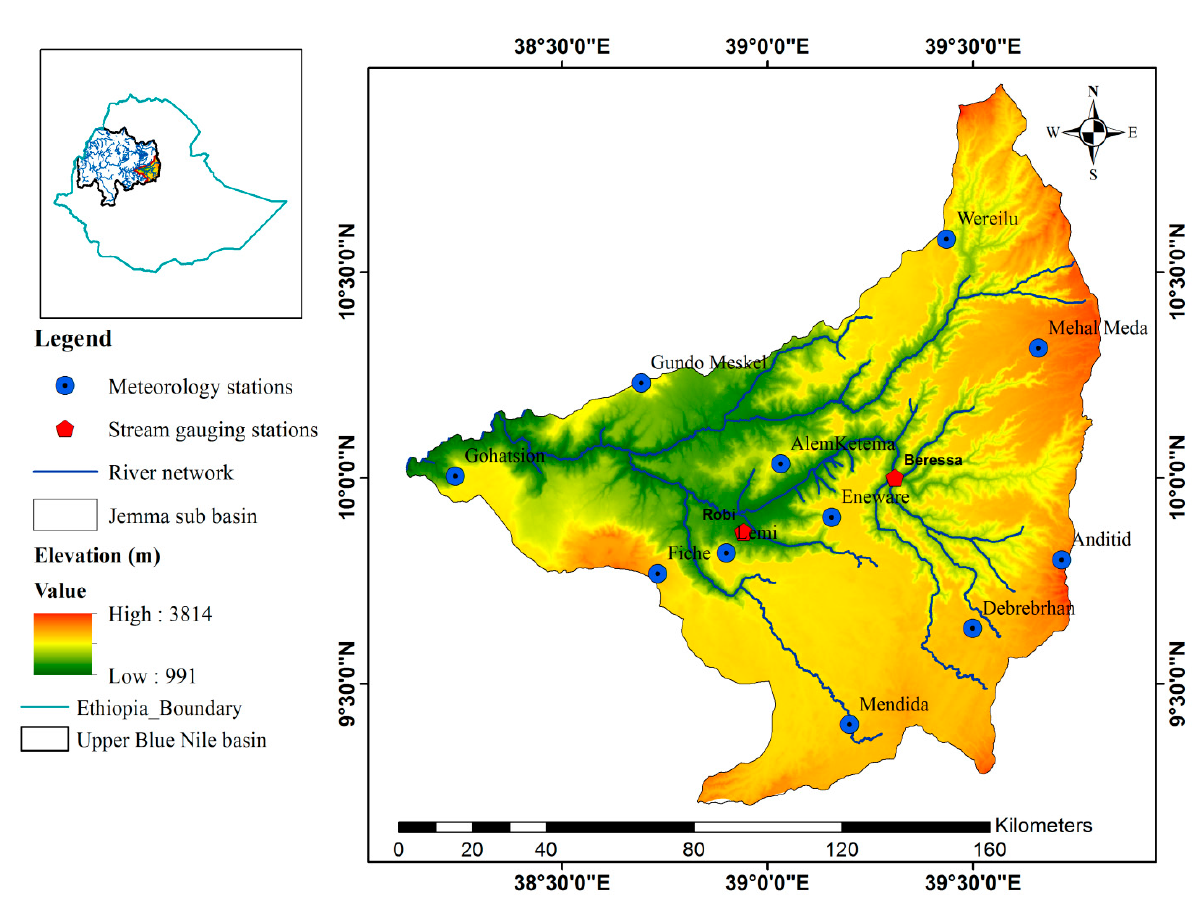
Figure 1. Locations of the Jemma sub-basin in the UBNB: meteorological stations, river networks, and stream gauging stations.